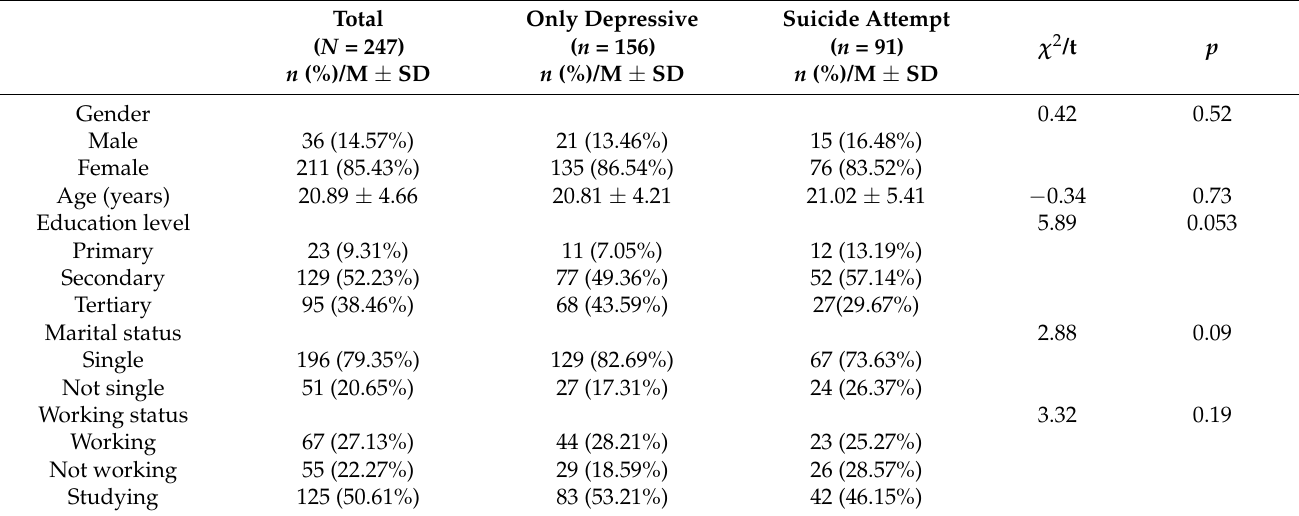
Table 1. Demographic characteristics of participants by suicidal